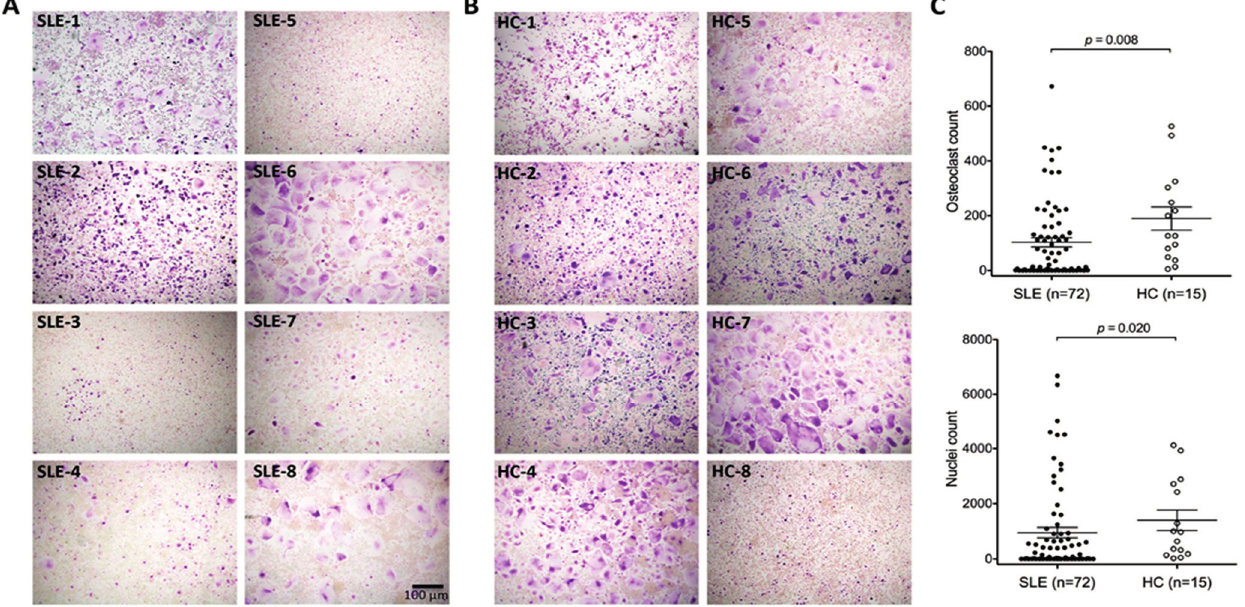
Figure 1. In vitro osteoclastogenesis is impaired in SLE patients. An example of images of TRAP stained osteoclasts for eight different ( A ) patients with systemic lupus erythematosus (SLE) and ( B ) normal healthy controls (HC); ( C ) Graphs show the osteoclasts and nuclei count out of three different wells for SLE patients and healthy controls. p -values were calculated by Mann-Whitney U